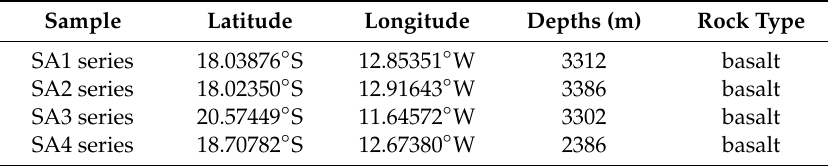
Table 1. Sample dredged locations and